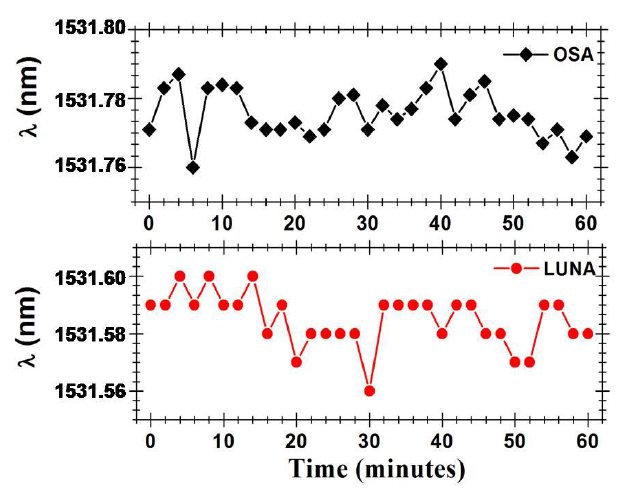
Figure 10. Output signal’s wavelength fluctuations over